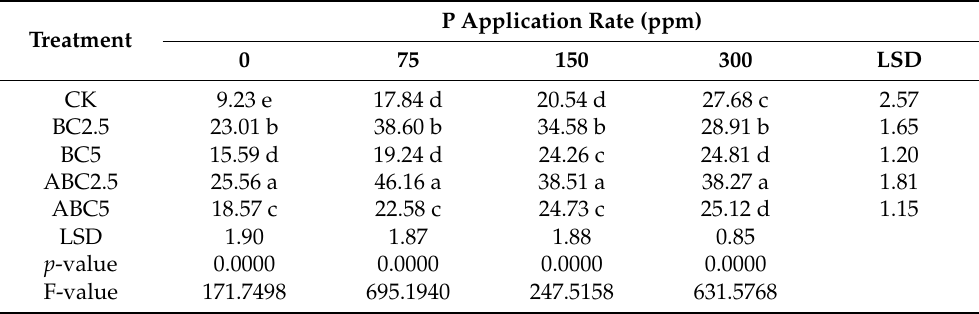
Table 14. Effects of BC and ABC applied at different rates with different P fertilizer application rates on plant height in